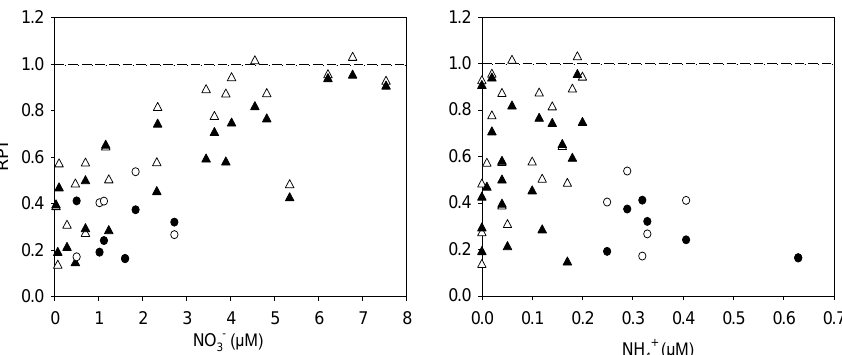
Fig. 8. Relationships between the ambient concentrations of NO − (RPI) for NO − calculated with D B included (solid symbols) or not (open symbols) for NH + 3 equal to (triangles) 0.2µM.